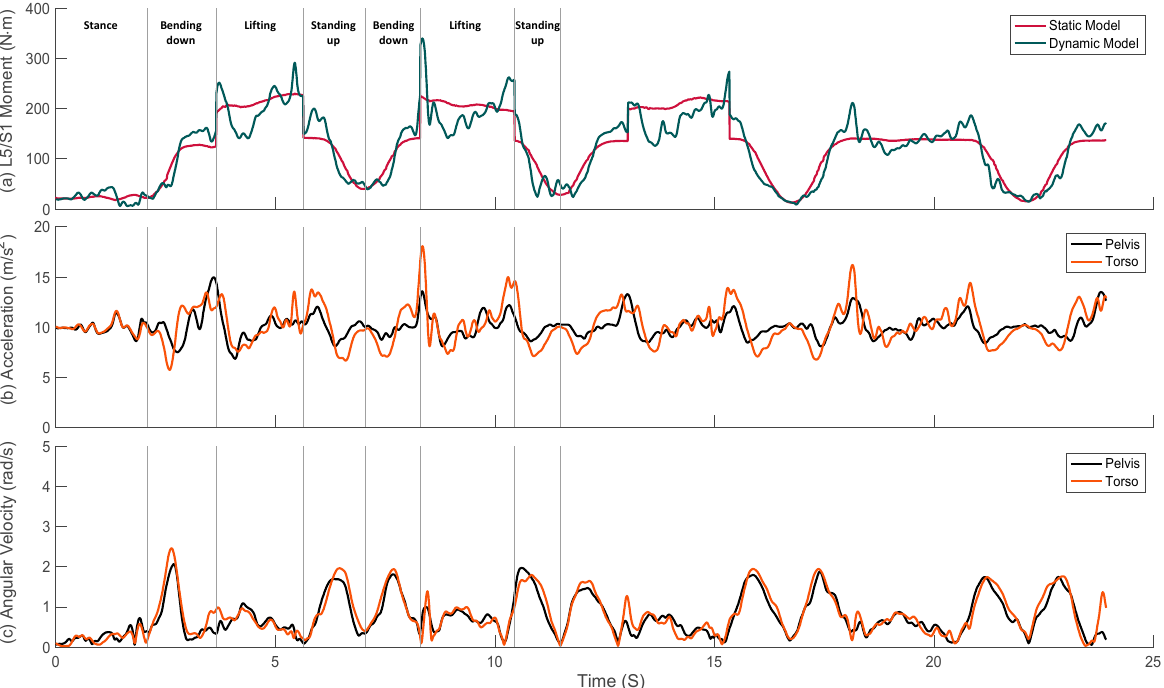
Figure 10. Typical examples of ( a ) predicted net L5/S1 joint moments by static (red line) and dynamic (dark-green line) models, ( b ) corresponding center of mass acceleration, and ( c ) angular velocities of the pelvis (black lines) and torso (orange lines) during lifting.